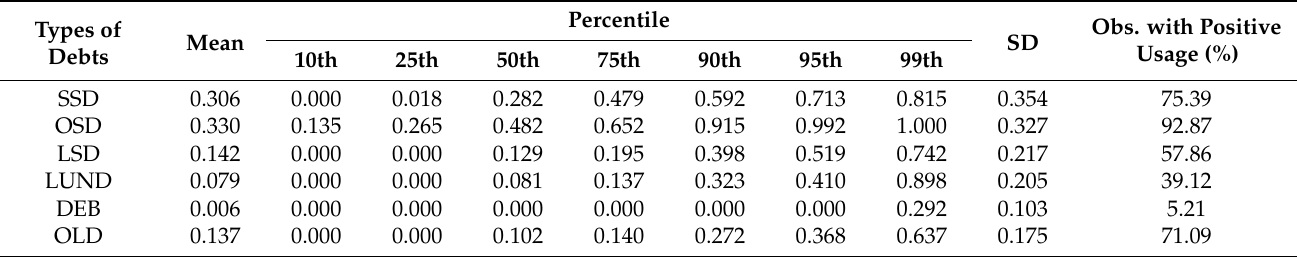
Table 3. Debt types